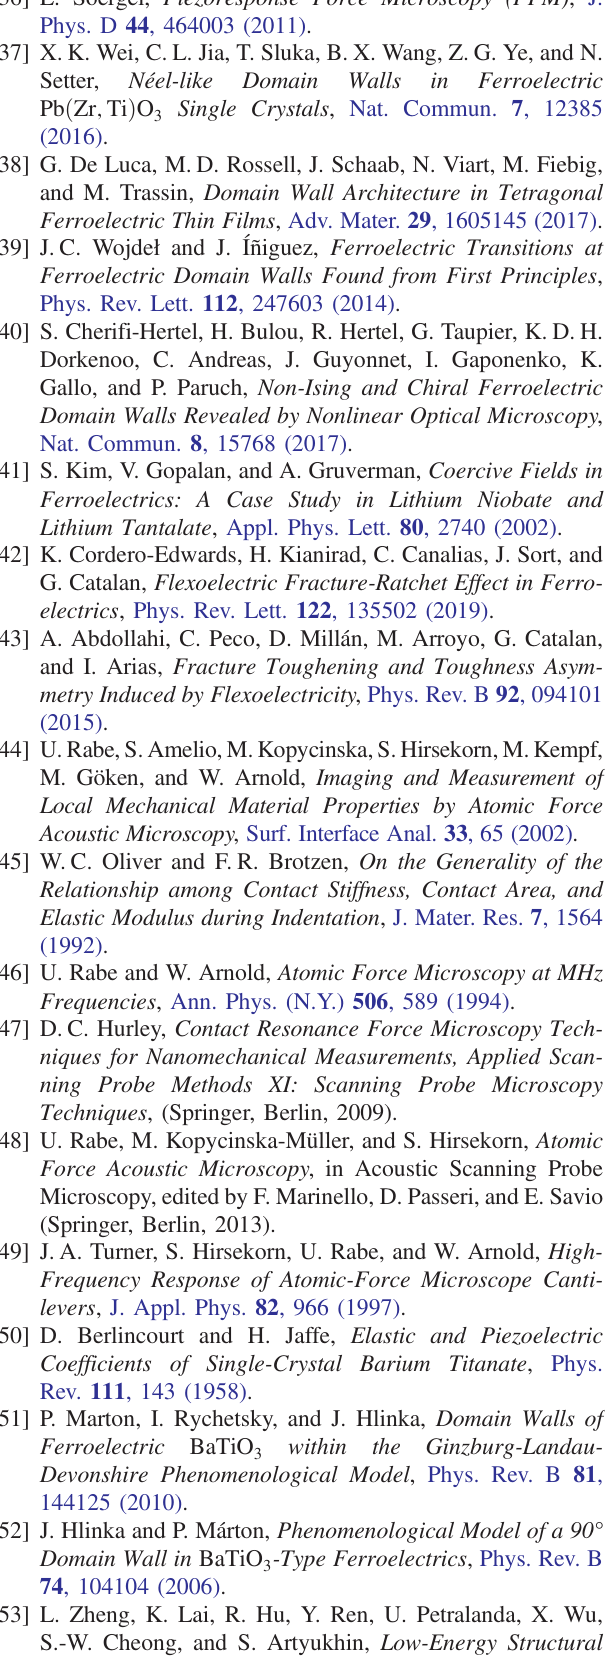
figurable Interfaces in Ferroelectric Thin Films , Nano Lett. 15 , 1791